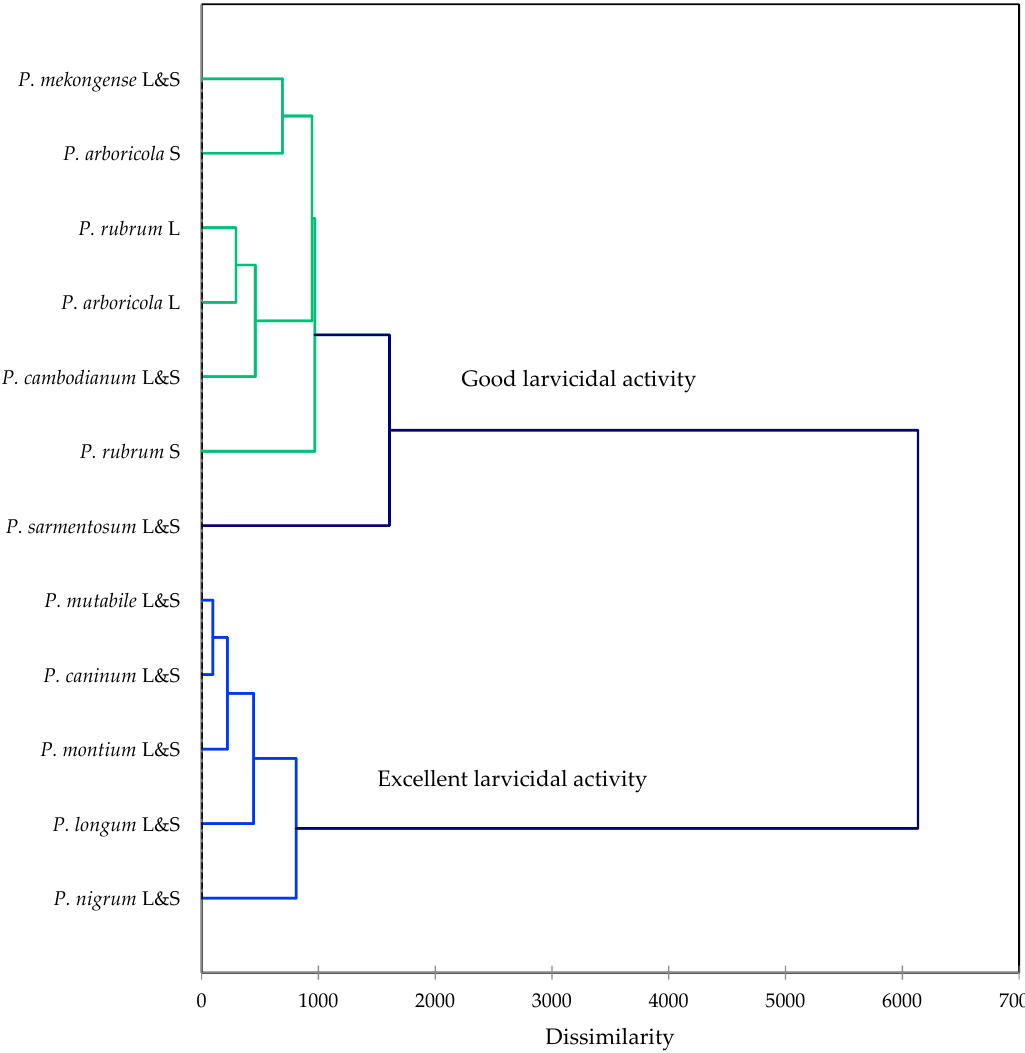
Figure 2. Agglomerative hierarchical cluster analysis based on the major components of the Piper essential oils from central Vietnam along with larvicidal activities (LC 50 and LC 90 ) against Aedes aegypti .